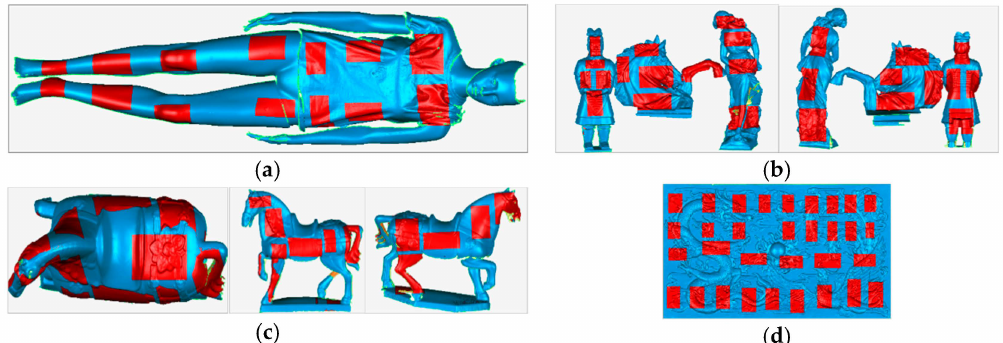
Figure 7. Selected location for the online experiment: the approximate relocation positions are marked by the red rectangles. ( a – d ) are selected locations of the model, small items, ceramic horse, and emboss objects.